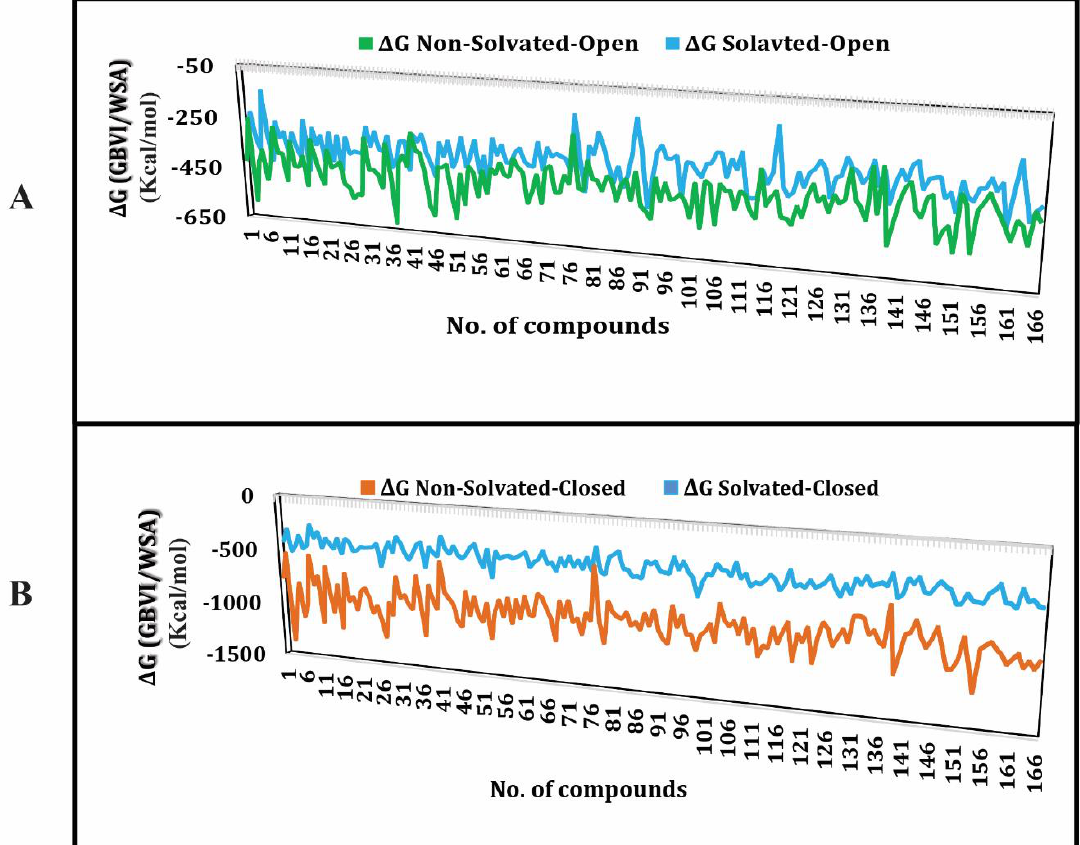
Figure 3. Plot showing binding free energies for the training data. ( A ) Binding free energies of training set docked in non-solvated (green) and solvated cryo_EM structure of hERG in the open conformational state. ( B ) Binding free energies of training set docked in non-solvated (brown) and solvated (blue) closed conformational state homology model of hERG. Int. J. Mol. Sci. 2019 , 20 , x FOR PEER REVIEW